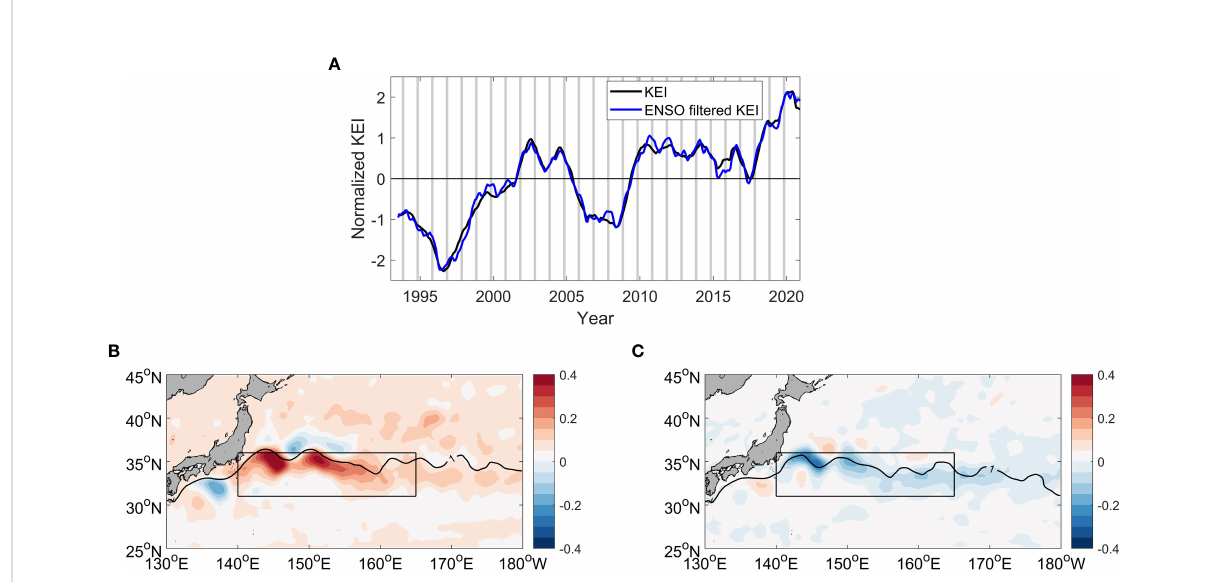
FIGURE 1 (A) The monthly normalized KEI time series before (black curve) and after (blue curve) ENSO fi ltering based on the AVISO SSHA observations. The gray bars mark out the KEI in OND. Composite SSHA (shading; unit, m) and corresponding KE axis (black curve) de fi ned by the 1-m sea surface height for the (B) SP and (C) USP during the period of 1993 – 2019, with black rectangle indicating the region used to calculate the KEI. KEI, Kuroshio Extension index; ENSO, El Niño Southern Oscillation; AVISO, Archiving, Validation and Interpretation of Satellite Oceanographic; SSHA, sea surface height anomaly; SP, stable period; USP, unstable